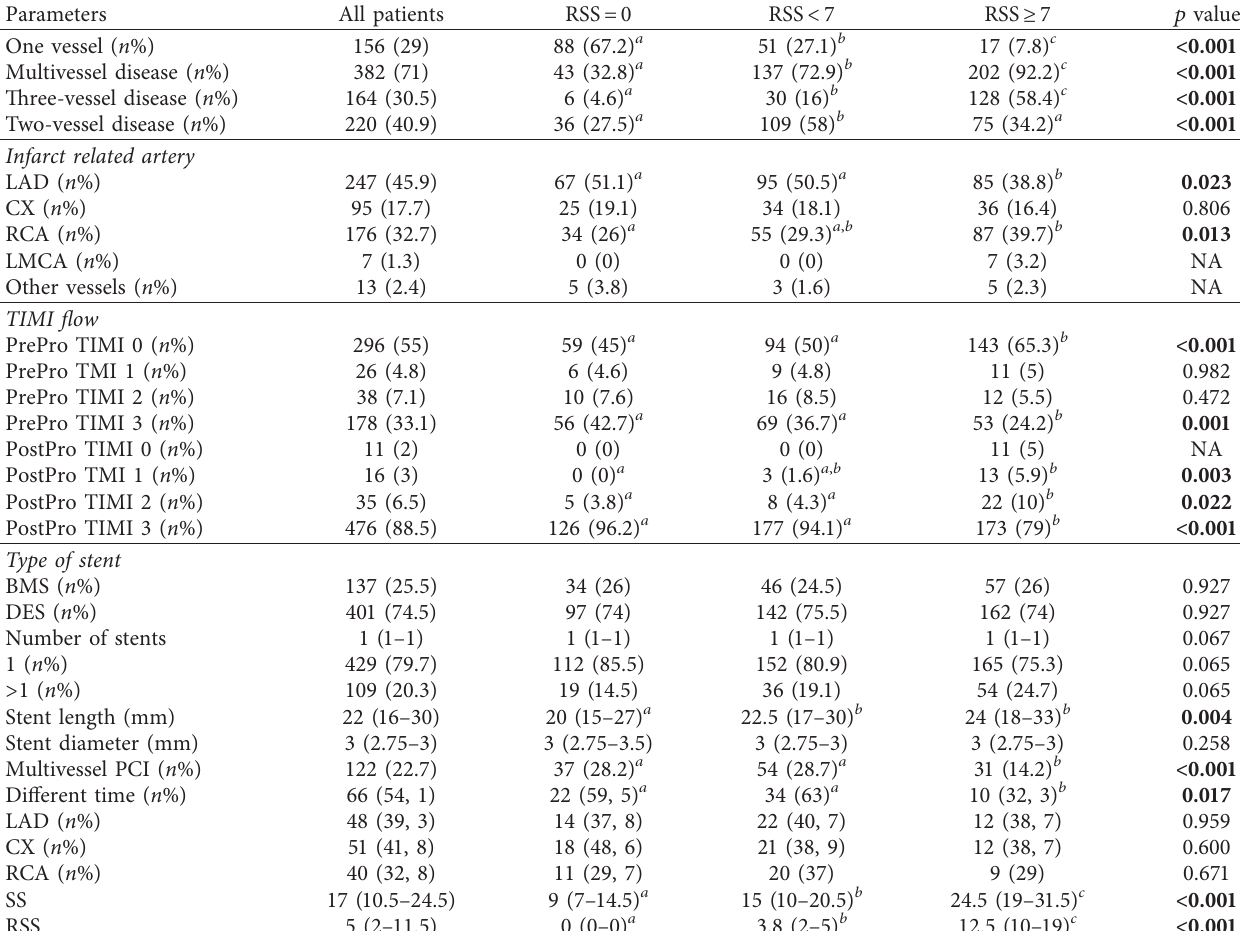
Figure 2: Correlation histogram between basal SS and RSS ( r � 0.727; p < 0 . 001) Spearman test. Table 2: In-hospital angiographic and procedural data characteristics and SS/RS scores of